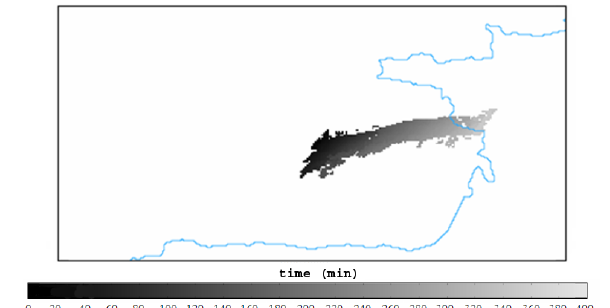
Fig. 015. Area covered by the contrail during the tracking. The Fig. 15. Area covered by the contrail during the tracking. The level level of gray indicates the age of the contrail. of gray indicates the age of the